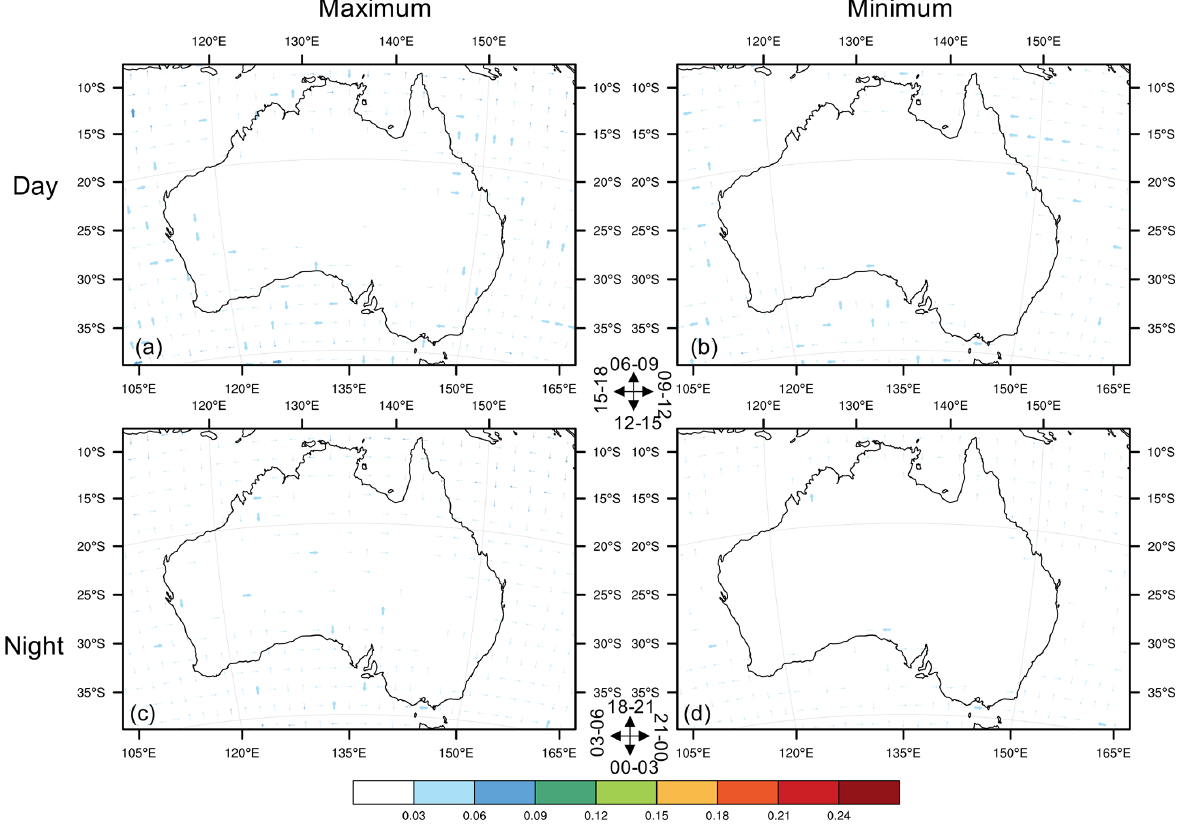
Figure 9. Diurnal (a, c) maximum and (b, d) minimum DAOD across Australia during the (a, b) daytime and (c, d) nighttime periods. Figure elements are the same as in Fig.